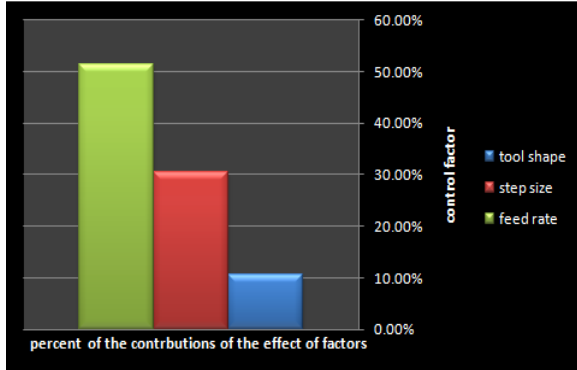
Fig. 17. Percentage contributions of means (45 ◦ wall